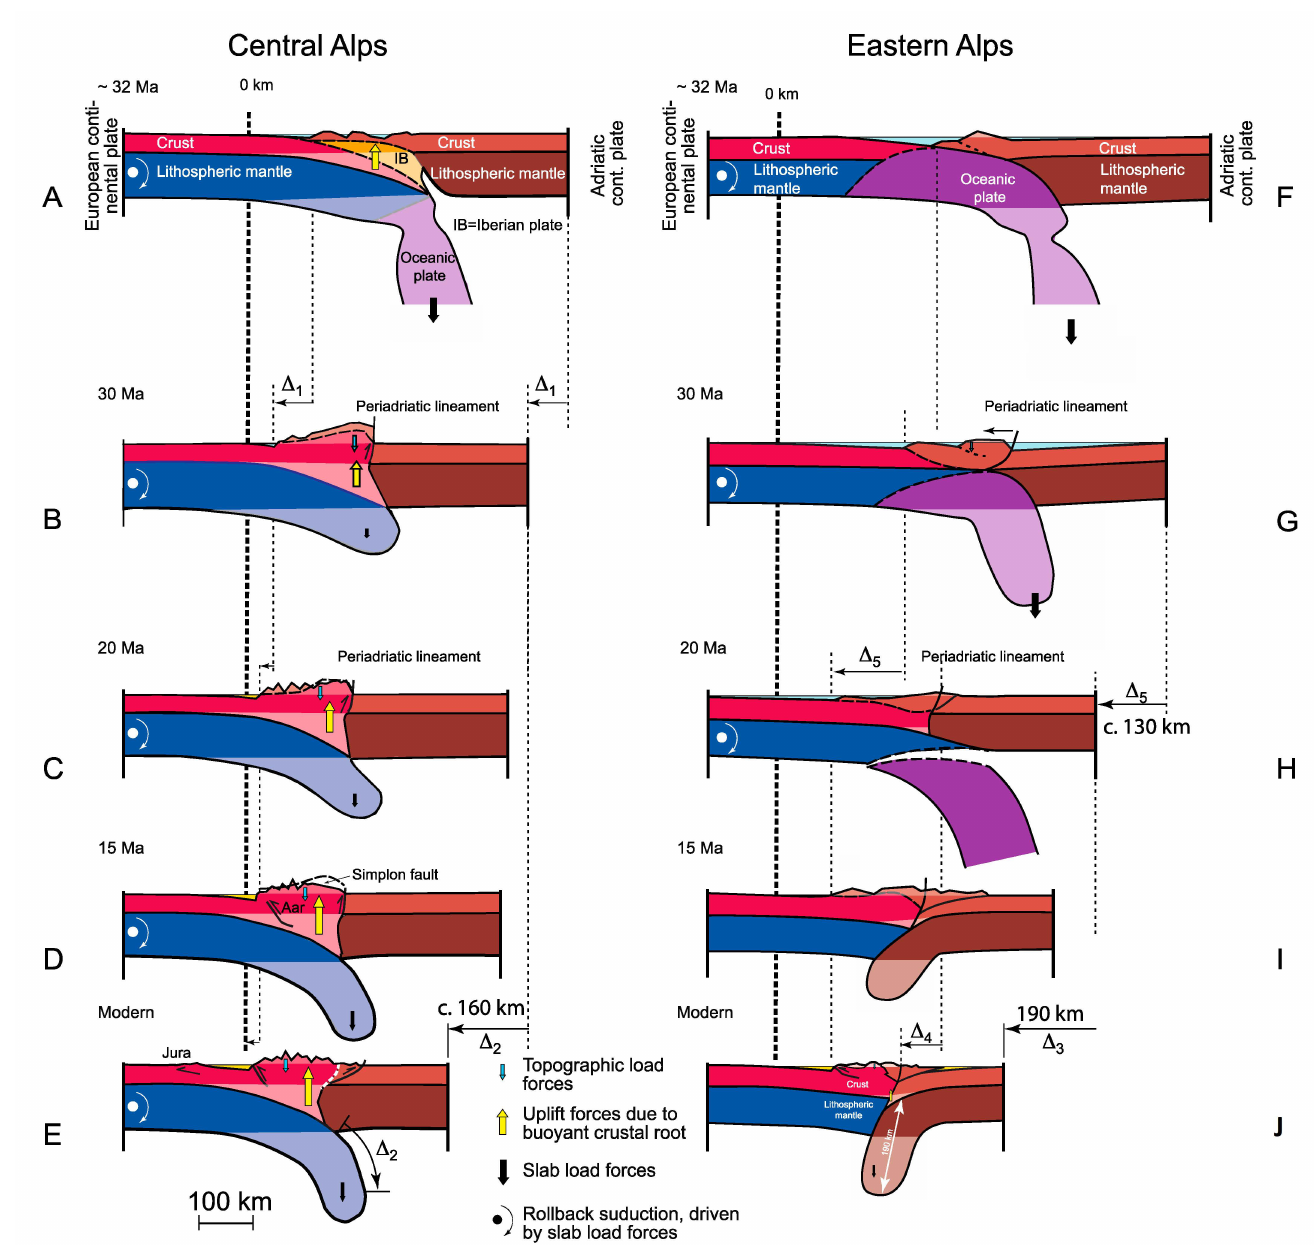
Figure 7. Tectonic evolution of the Alps. See Figure 2 for location of cross sections. ( A ) At 35–32 Ma, the Iberian plate was accreted to the Central Alps, forming a stack of buoyant crustal rocks. The oceanic slab, which has a high density, and which deflected the foreland plate towards the South, was still attached to the European plate. ( B ) At 32–30 Ma, the resistance of the crustal root to enter the subduction channel resulted in slab-breakoff where the dense oceanic slab was removed from the continental plate. This latter plate experienced a rebound because of the removal of the downward-directed slab force and driven by the buoyancy of the crustal root. The result was the incipient rise of the Alpine topography between 30–25 Ma. ( C – E ) After 30 Ma and beneath the Central Alps, the lithospheric mantle slab has continued to be delaminated from the continental crust and to be subducted but remained attached to the European plate. Beneath the Eastern Alps ( F ), no Iberian crustal rocks were accreted, and buoyant material was largely missing. The oceanic part of the European plate was attached to the continental plate and deflected the foreland plate towards the